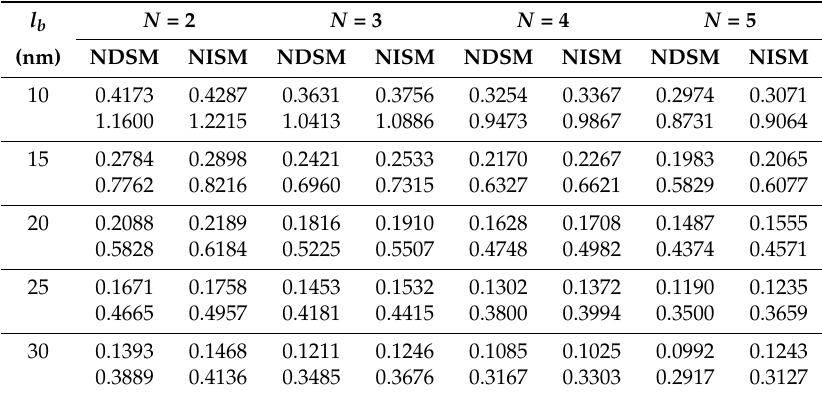
Table 3. A verification between the predicted first two longitudinal frequencies of the magnetically affected nanorod with FIFR ends according to the NDSM and those of the NISM (¯ k i = 3, D 0 = 4 nm, e 0 a = 1 nm, ¯ H y = ¯ H z = 1).